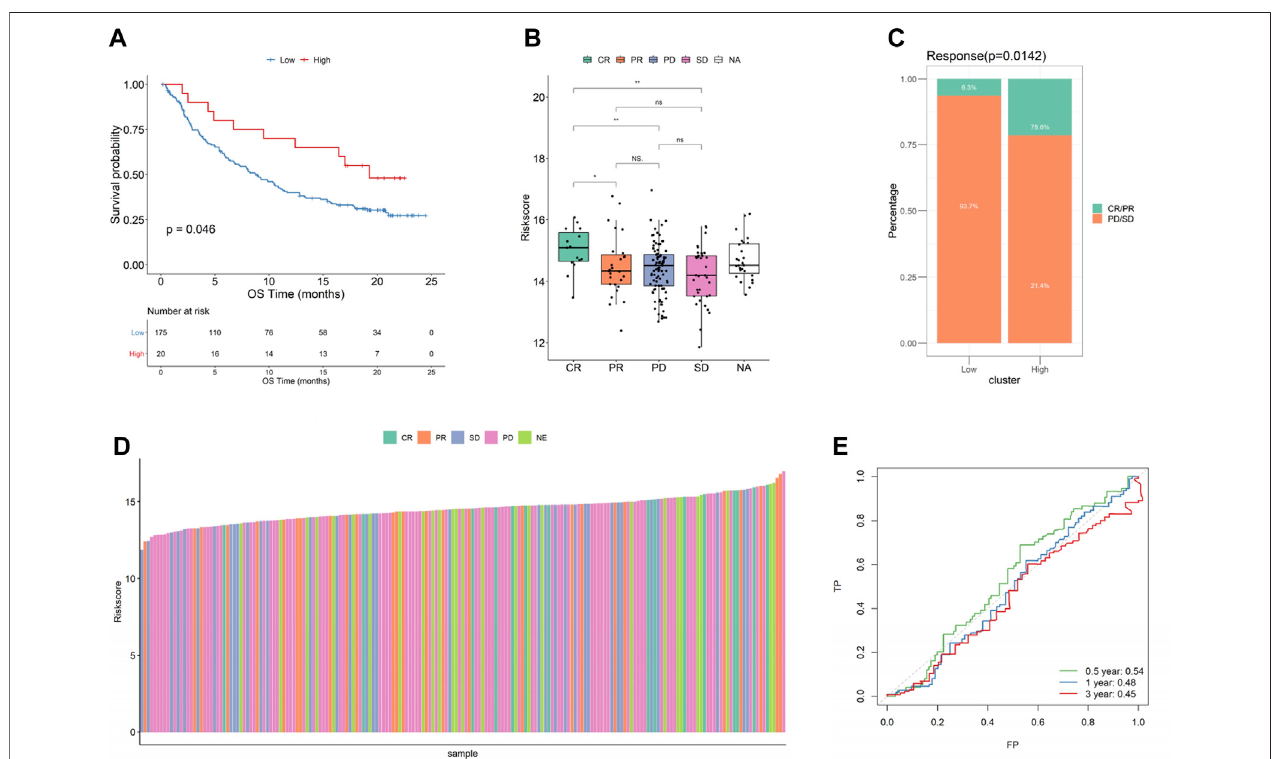
FIGURE 10 | Relationship between risk score and effect of immunotherapy in bladder cancer. (A) KMcurve; (B) Riskscore distribution of different ef fi cacy groups; (C) Distributionofdifferentimmuneef fi cacygroupsinthehigh-andlow-riskscoregroups; (D) Riskscorehistogramofdifferentef fi cacygroups; (E) ROCcurveatdifferent times (bladder